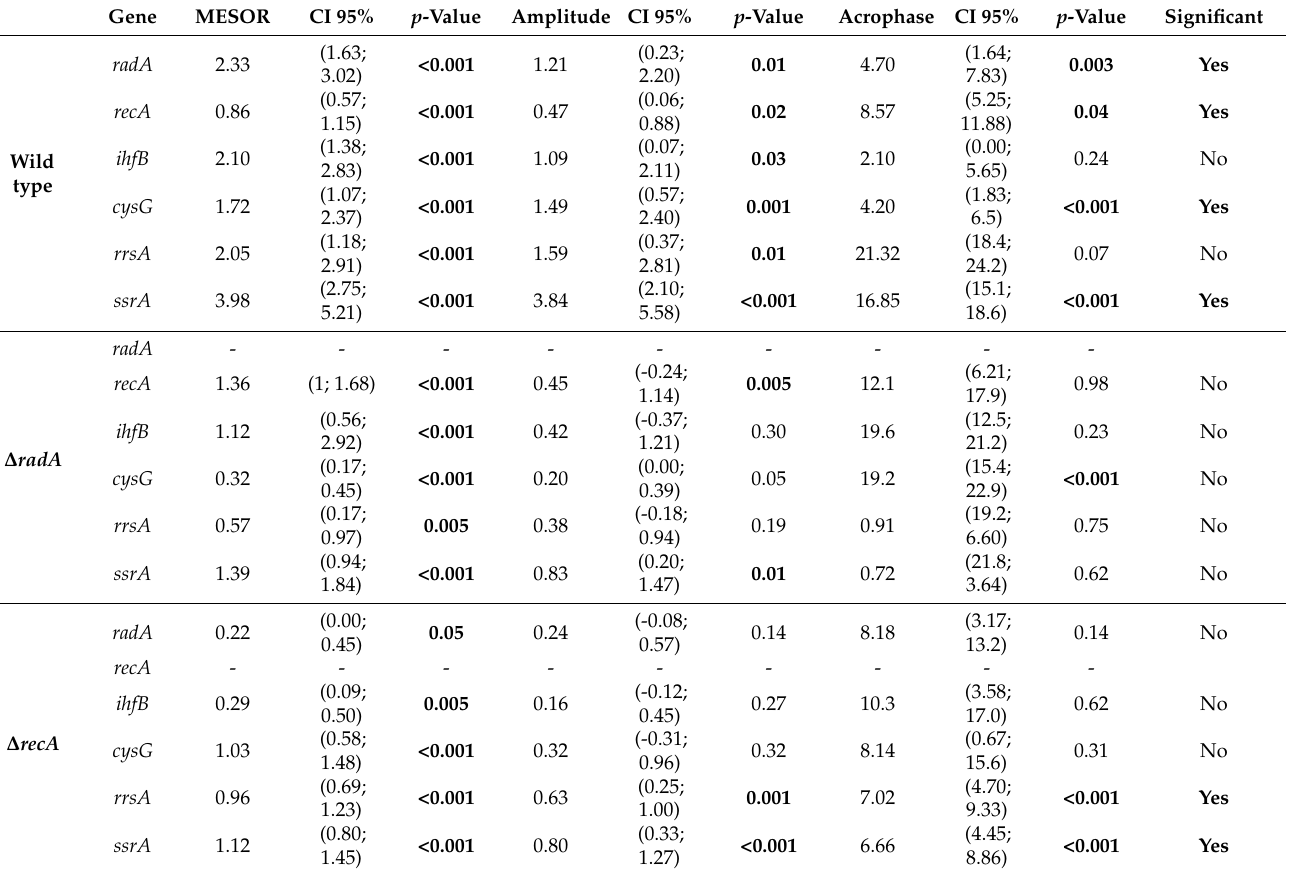
Table 1. Rhythmic parameters (MESOR, amplitude, and acrophase) of investigated